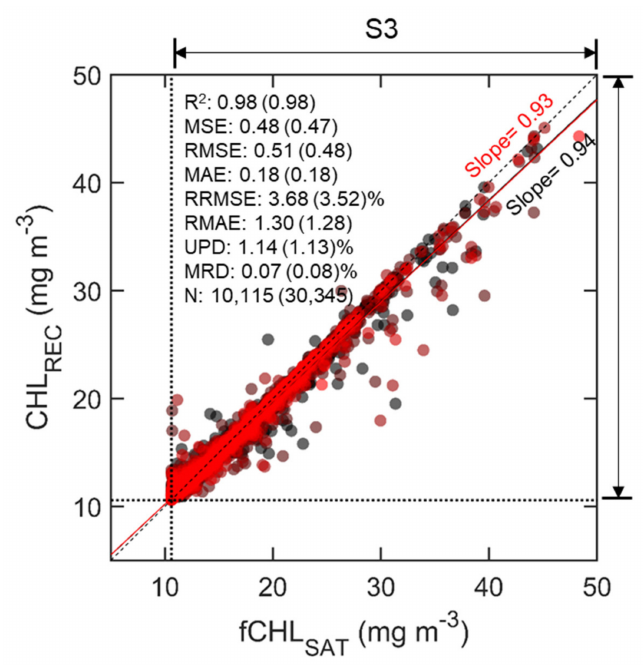
Figure 8. Scatter plots for testing the adjusted RF model performance at segment S3 (high CHL values with 10.59 mg m − 3 ). Refer to Figure 7 for